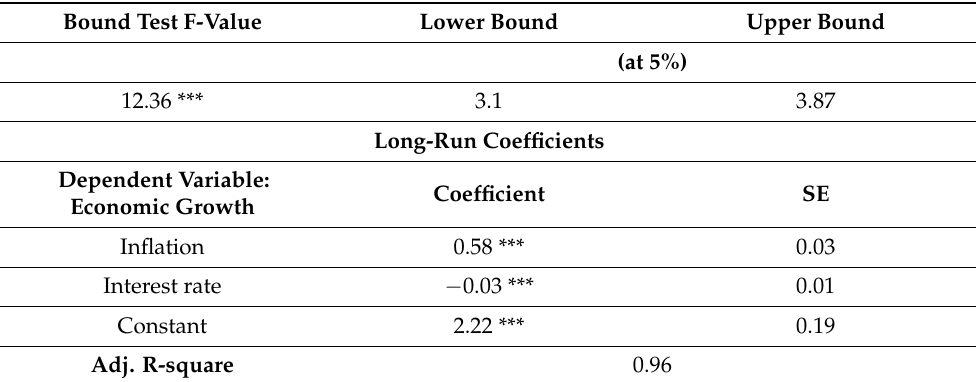
Table 3. Results of ARDL cointegration.